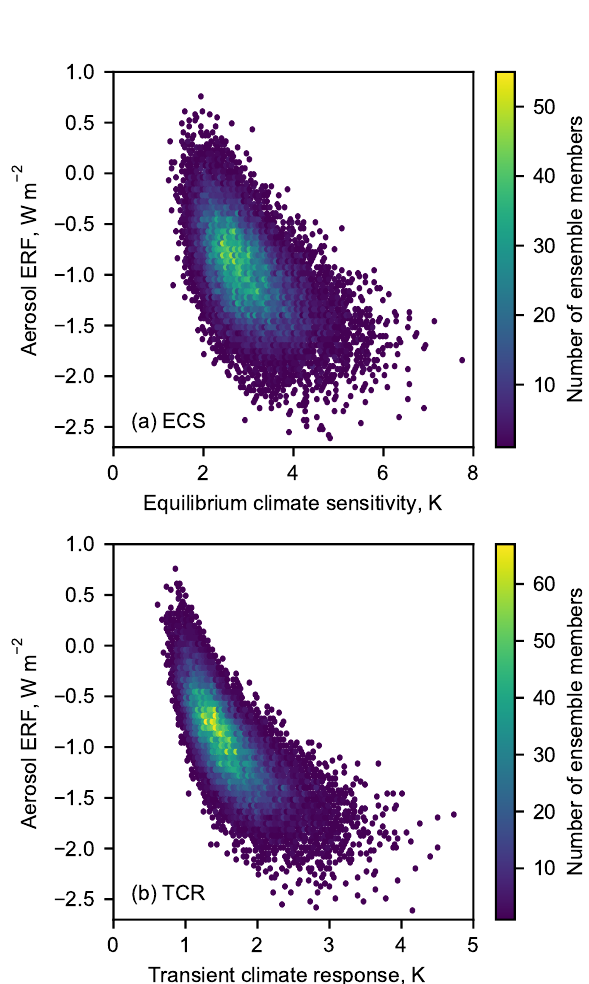
Figure 7. Relationship between (a) ECS and aerosol ERF; (b) TCR and aerosol ERF for the NROY ensemble. Aerosol ERF is shown for 2017 under the RCP8.5